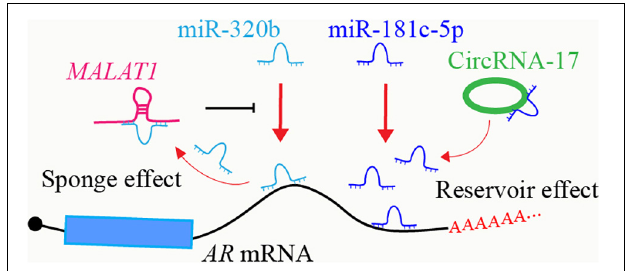
FIGURE 1 | Crosstalk between ncRNAs in AR regulatory network. LncRNA MALAT1 acts as a sponge to inhibit miR-320b-targeted AR mRNA degradation. CircRNA-17 binds to and stabilizes miR-181c-5p, enhancing miR-181c-5p-targeted AR mRNA